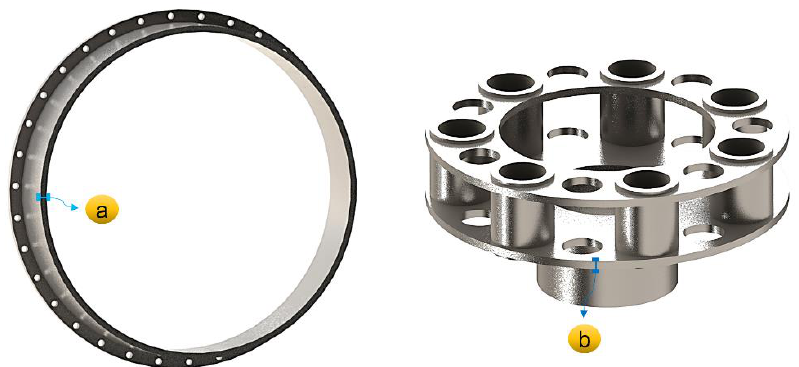
Figure 18. Sensitivity dimensions of system performance indexes: ( a ) rim thickness of the ring gear ( b ) base plate thickness of the planet carrier.